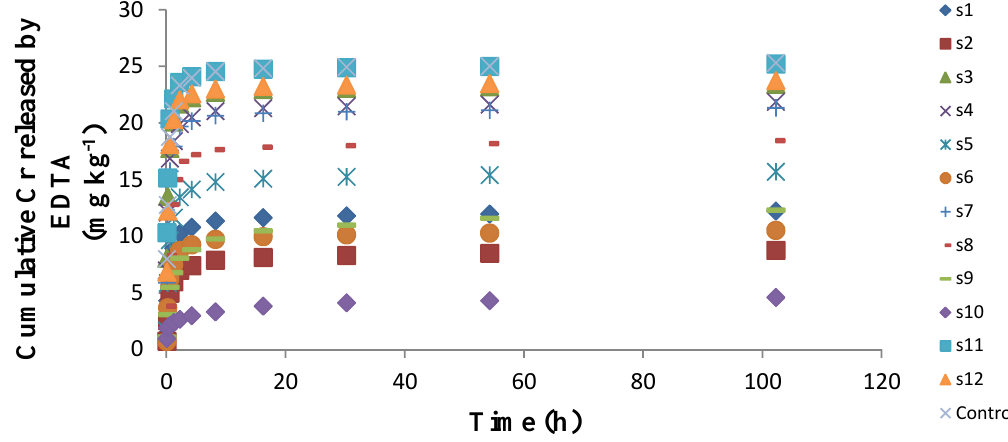
Figure 3. Variation of Cr desorption by 0.01 m EDTA in time in treated soils